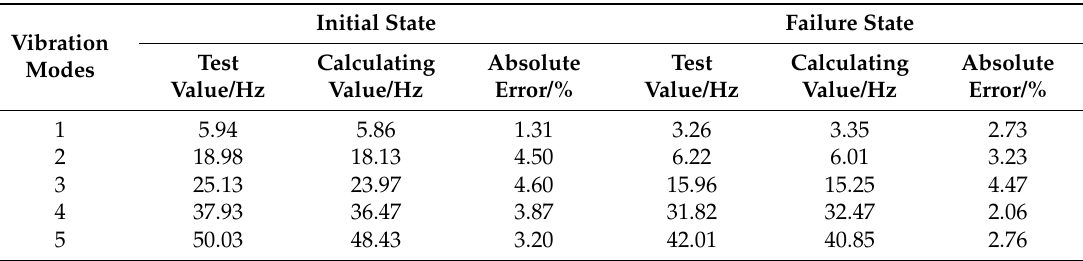
Table 5. Comparison of